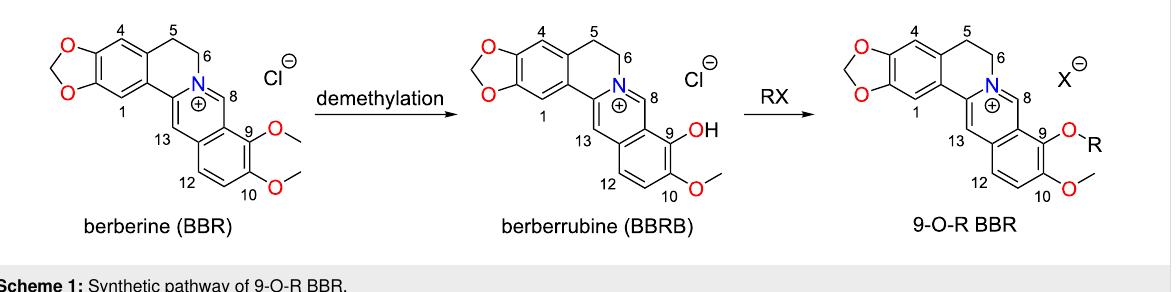
multidrug-resistance pump inhibitor